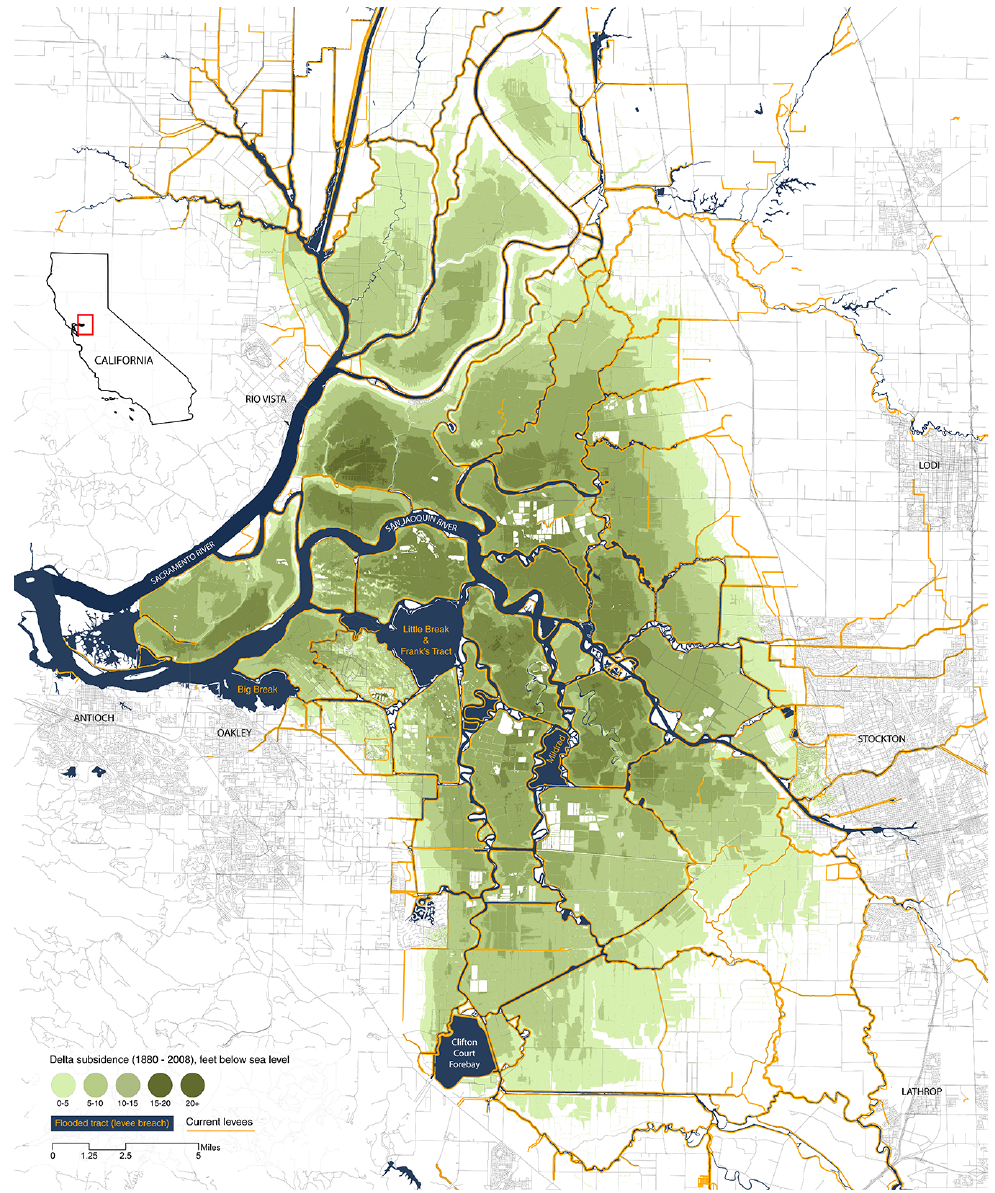
Figure 1. Delta levees, subsidence, and urbanization: once exposed to air through reclamation and the construction of an extensive network of levees (over 1,100 miles), the Delta’s peat soils have oxidized and subsided up to 30 feet below sea level, which in turn places greater stress on levees. The Delta is surrounded and encroached upon by expanding urbaniza- tion from multiple cities and population centers (Data generated by 2008 Lidar from the California Department of Water Resources). Map by Brett